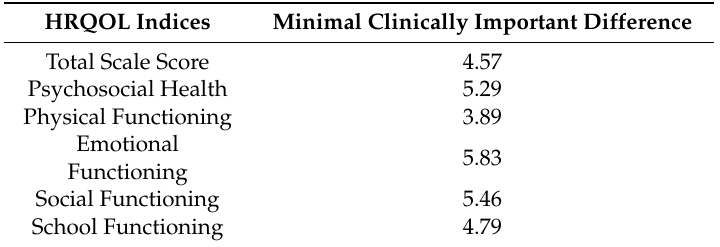
Table 1. Minimal clinically important difference for health-related quality of life (HRQOL) indices.